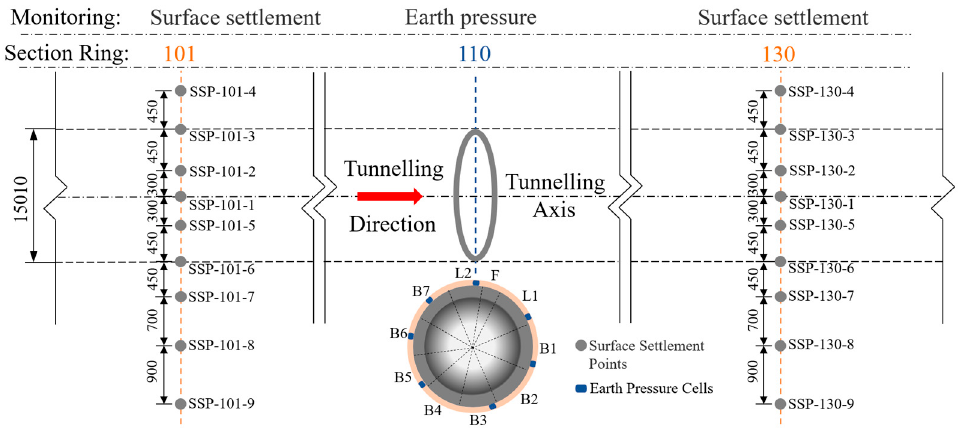
Figure 4. The layout of monitoring points for surface settlement and pressure gauges outside tunnel segments.